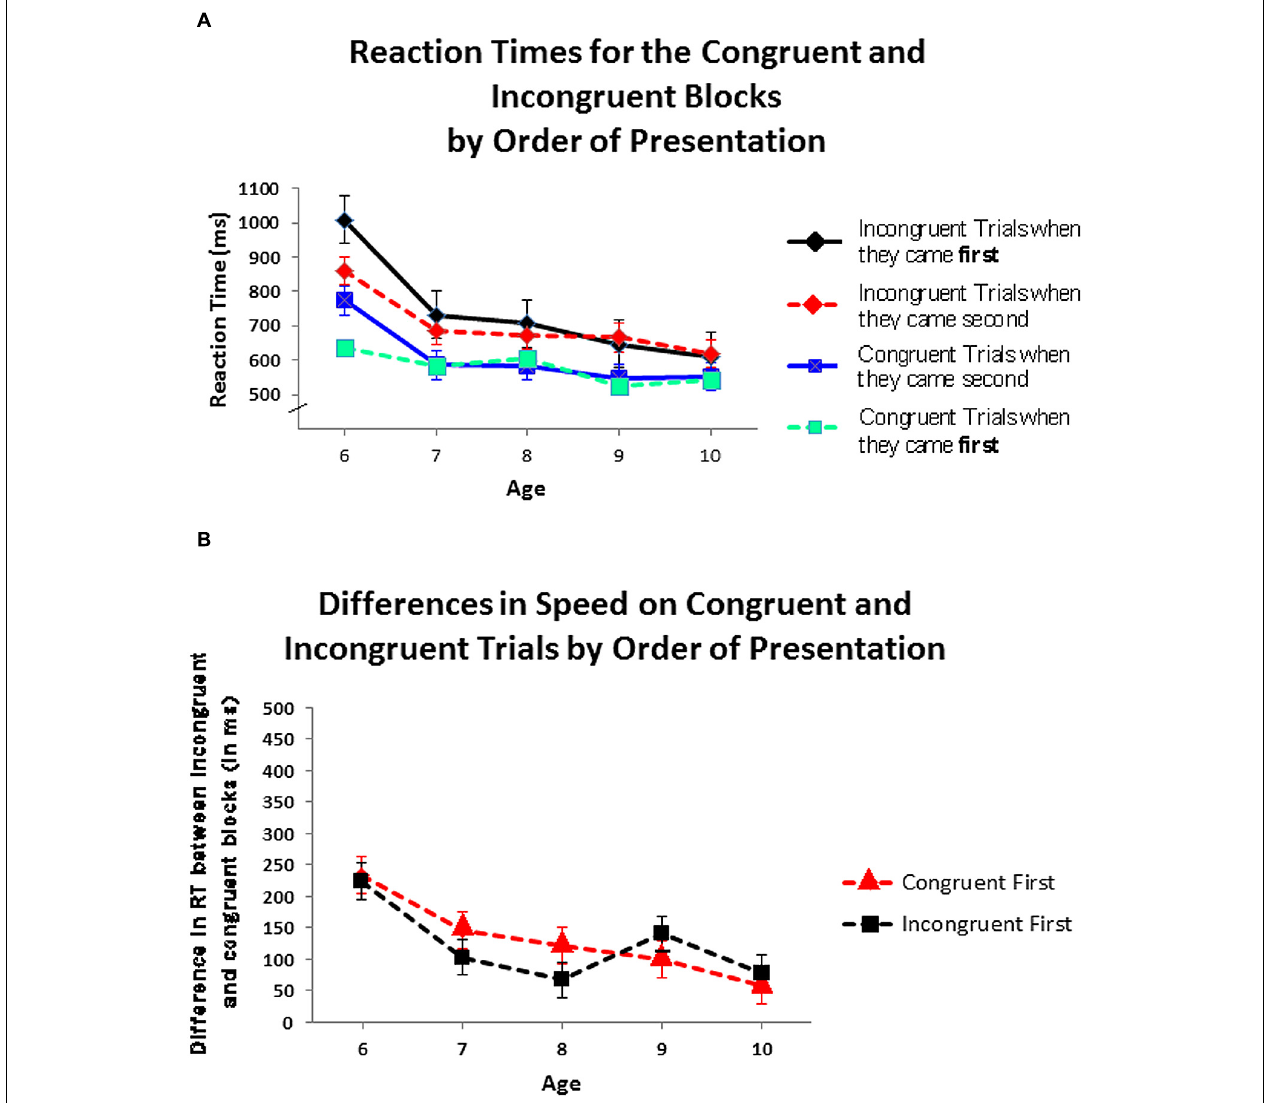
FIGURE 3 | (A) Speed of responding on the congruent and incongruent blocks by order of presentation. (B) Differences in speed on incongruent and congruent trial blocks by order of presentation.Values greater than zero, as all are, indicate that children responded faster on congruent than on incongruent blocks.